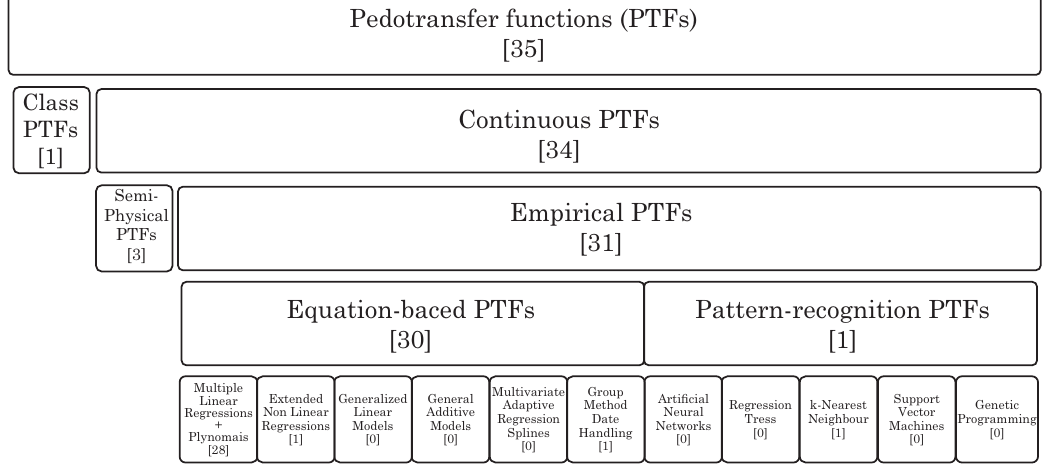
Figure 5. Categorization of pedotransfer functions (PTFs) to predict water retention. The number in brackets represents the number of publications in which a type of PTF has been developed to predict water retention of soils in the humid